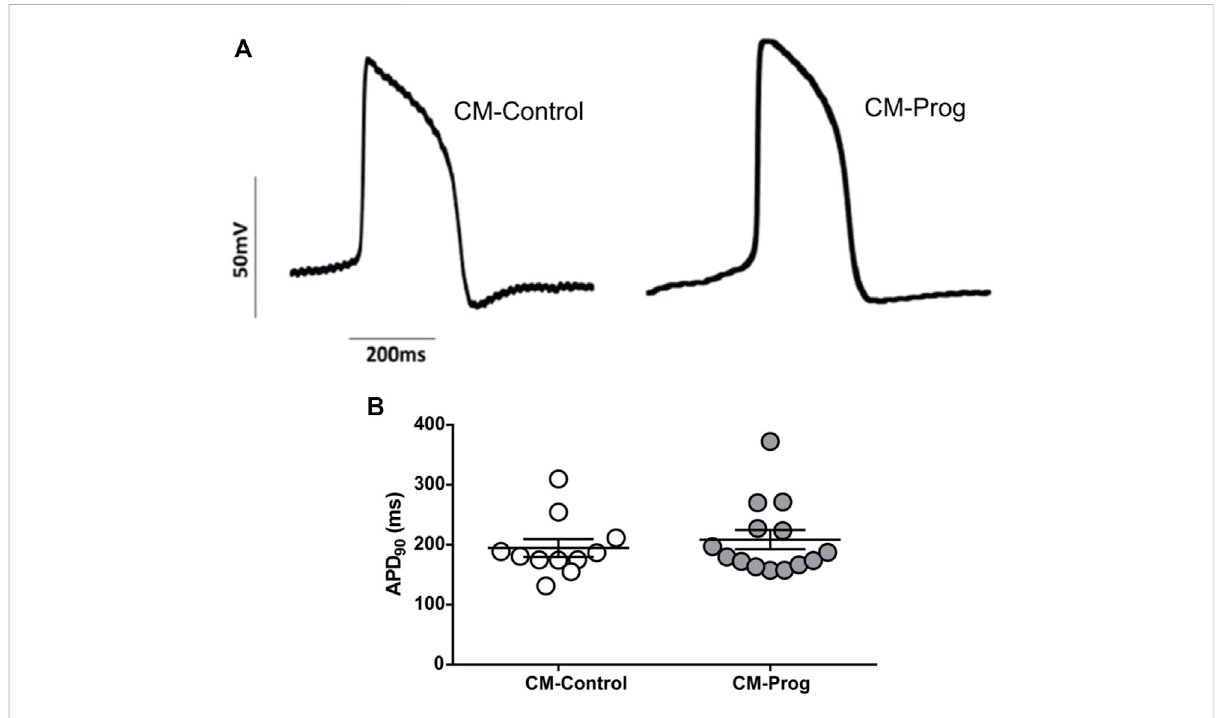
FIGURE 3 Electrophysiological characterization of iPSC-derived cardiomyocytes (A) Representative traces of action potential recordings in spontaneously contracting ventricular-like cardiomyocytes, from both control (CM-Control) and HGPS (CM-Prog) from three distinct cellular differentiations. (B) Action potential duration at 90% of repolarization (APD90). Scatter plot shows values from individual cells, where horizontal bars representmeanvalueswithSEM.Eachdotrepresentstheactionpotentialofadifferentcellandstudent ’ st-testwasapplied(CM-Control n =11; CM-Prog n =